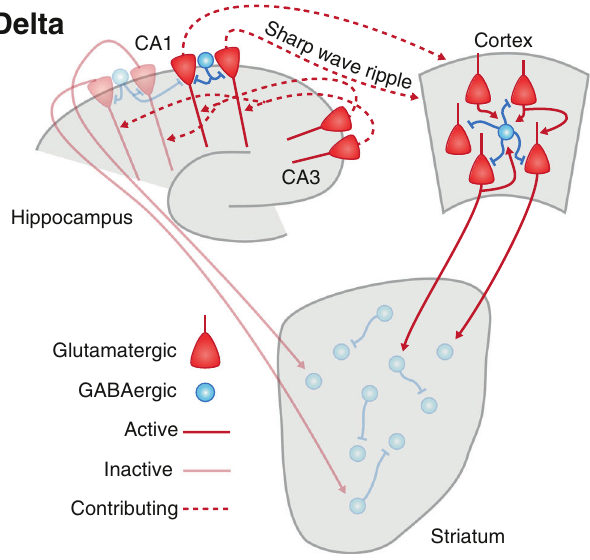
Fig. 1 Delta oscillations arise from the propagation of activity throughout the cortex. SWRs in the hippocampus are correlated with the phase of delta oscillations. Striatum also exhibits delta that is driven by cortical